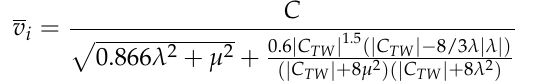
Figure 2. Definition of coordinate systems. where O is the center of gravity of the QTR; V is the inflow velocity; O D X D Y D Z D is the inertial coordinate system; OXYZ is the body coordinate system; O W X W Y W Z W is the wind axis; O S X S Y S Z S is the rotor fixed axis coordinate; O SW X SW Y SW Z SW is the rotor wind coordinate, in which O SW X SW is the projection of the velocity V onto the O SW X SW Y SW plane; β sw , the side-slip angle of the rotor is the angle between O S X S axis and O SW X SW axis.